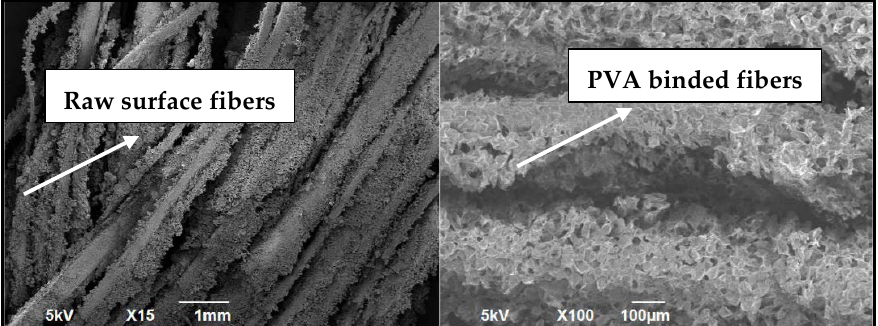
Figure 15. SEM image of raw date palm fibers ( left side ) and the prepared insulation composite ( right side ).